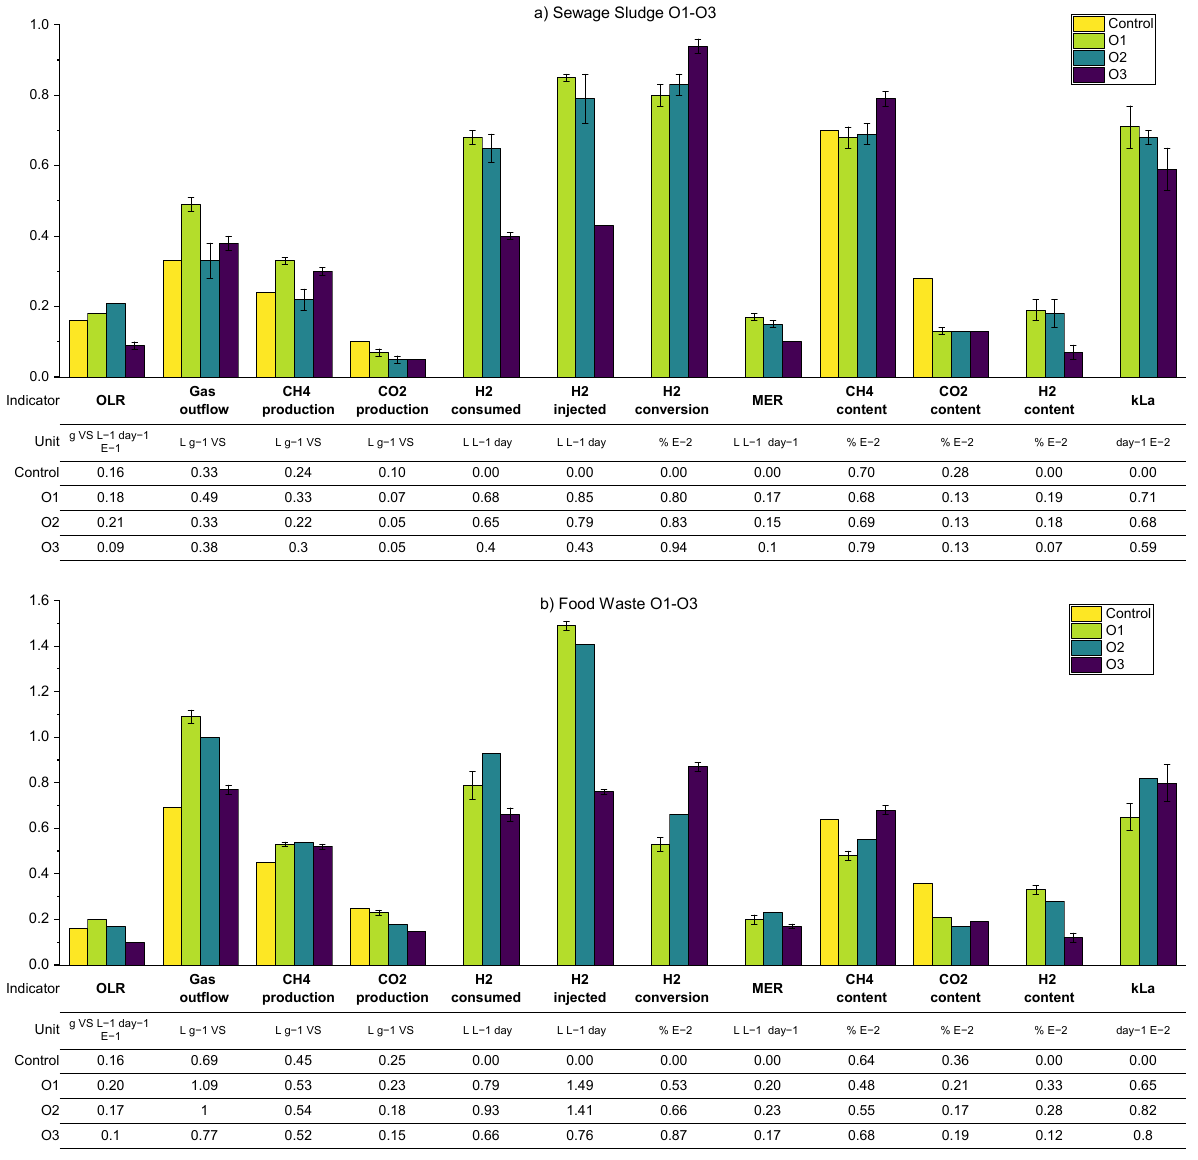
Figure 12. Summarised biomethanation experimental results; periods O1-O3 using SS ( a ) and FW ( b ). Error bars show duplicate reactor averages, and E notation is used to scale results to the same vertical axis.